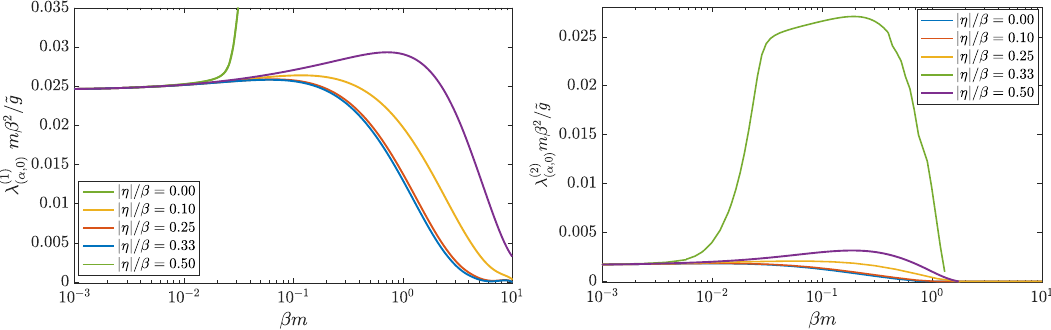
Figure 6 . Contour dependence of the Lyapunov spectrum in the weakly coupled (cid:8) 4 -matrix model . Two largest Lyapunov exponents of Lyapunov spectrum of the matrix (cid:8) 4 theory as a function of the coupling. Each value of (cid:17) , de(cid:12)ned in eq. (3.14), corresponds to a di(cid:11)erent contour choice: (cid:17) =